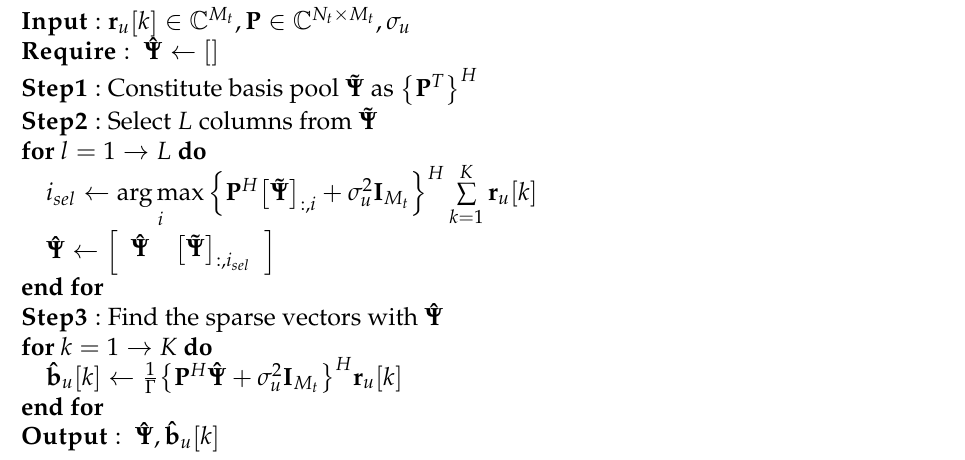
Algorithm 1 Search of Common Sparse Basis and Corresponding Sparse